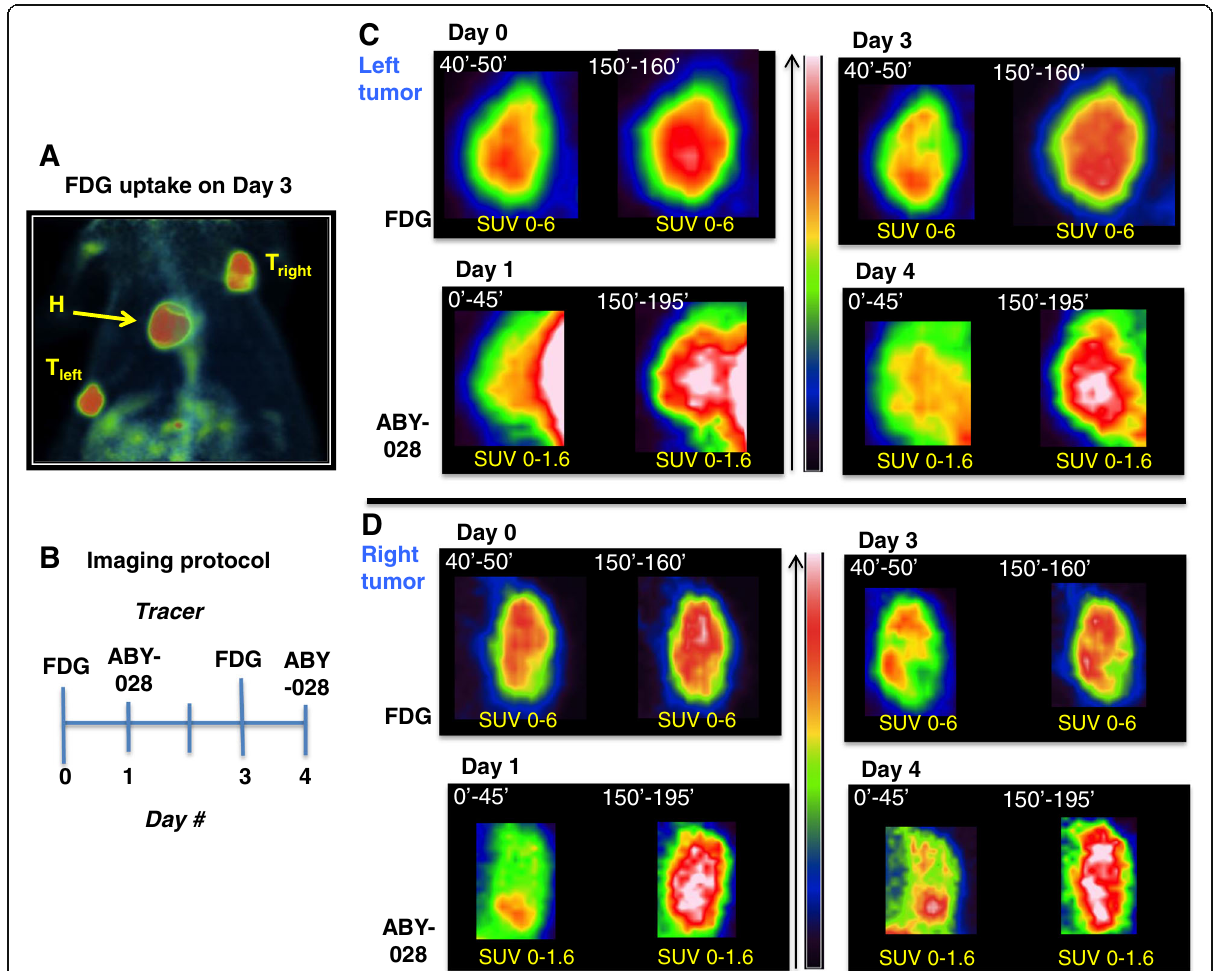
Fig. 7 Comparison of changes in metabolism and permeability with tumor progression in a NIH-Foxn1mu rat bearing two FaDu xenografts. a Maximum intensity projection PET image of [ 18 F]FDG uptake on day 3 showing the localization of the xenograft tumors (T) to the left and right; H, heart. b The time line for imaging experiments. c , d Coronal PET images for the left and right tumors, respectively: the top rows are of [ 18 F]FDG uptake on day 0 and day 3, dual time imaging on each day, and the bottom rows are of [ 68 Ga]ABY-028 uptake on day 1 and day 4, dual time imaging on each day, but at different times for the two tracers (shown immediately above each image). The same magnification was used in the images. The bar shows the color scale used. Note: to facilitate visual comparisons the SUV mean , ranges in the color bar are the same for all the [ 18 F]FDG images (0 – 6) and for all the [ 68 Ga]ABY-028 (0 – 1.6), but are different for the two tracers due to their differing levels of total